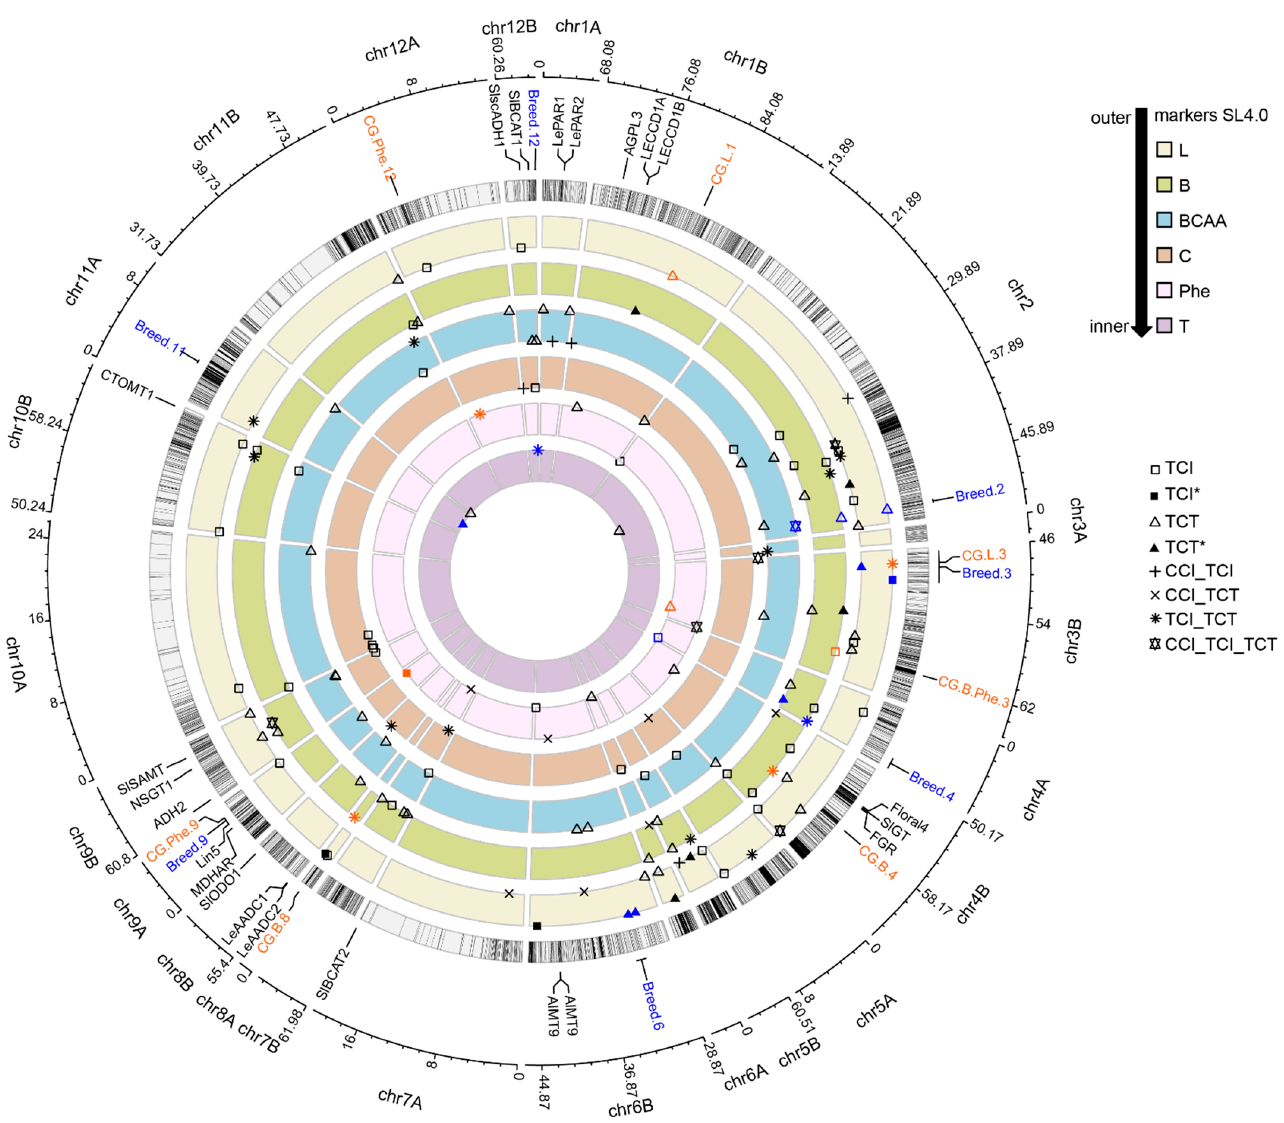
Figure 3. Circos plot of associations found for VOCs impacting tomato aroma. The outmost lane gives the marker density on the 12 chromosome arms (centromeric region are not displayed). Each successive lane represents a specific metabolic pathway. Association shape depends on the panel in which they were found. An asterisk (*) indicates overlapping asso- ciations from the same panel, with only one association plotted in case of overlap. Associations with pval < 10 − 6 are plotted on the outer end of the lane, otherwise they are plotted on the inner end of the lane. We displayed positions of cloned genes impacting tomato aroma, along with the breeding (blue) and candidate gene (orange) regions we selected on top of the marker lane.